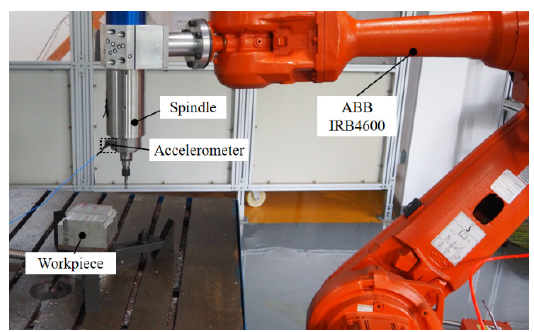
Figure 13. Milling test system setup.